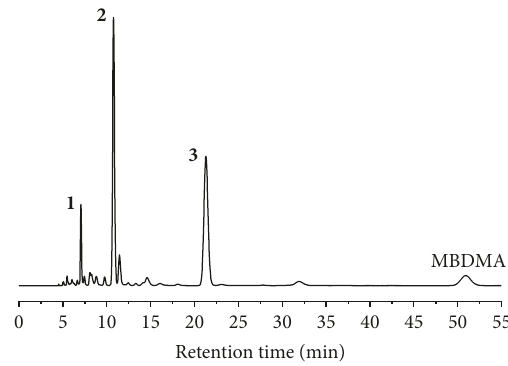
Figure 1: The liquid chromatogram of the filtrate obtained after the reaction of MDA with